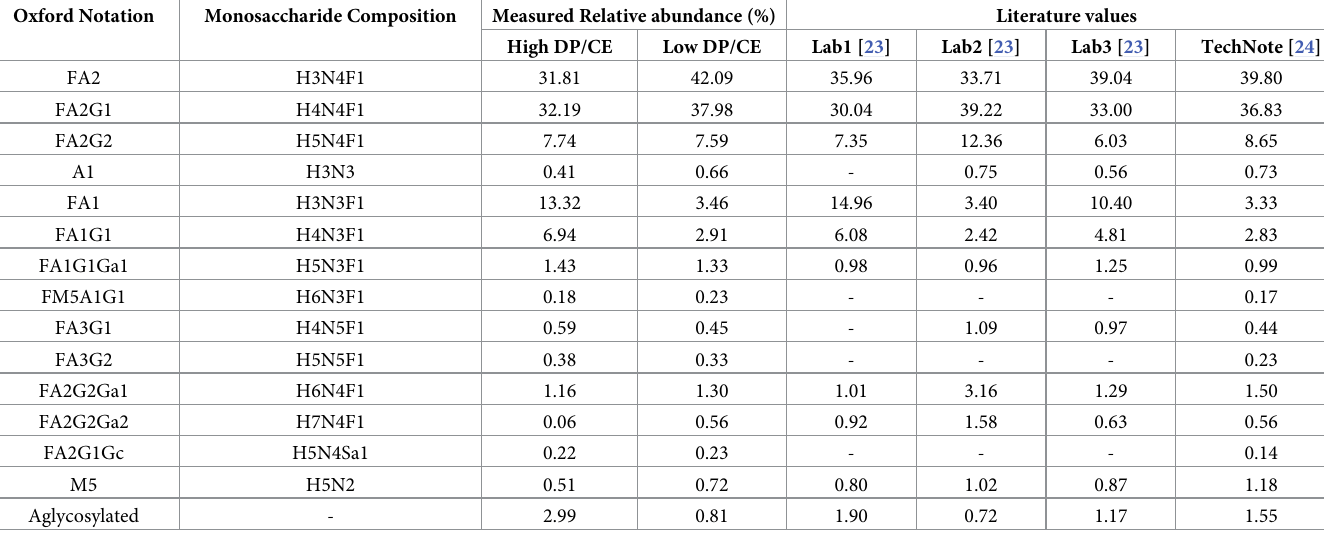
Table 1. NIST-RM glycan structures identified using MAM workflow and their relative abundance. Oxford Notation Monosaccharide